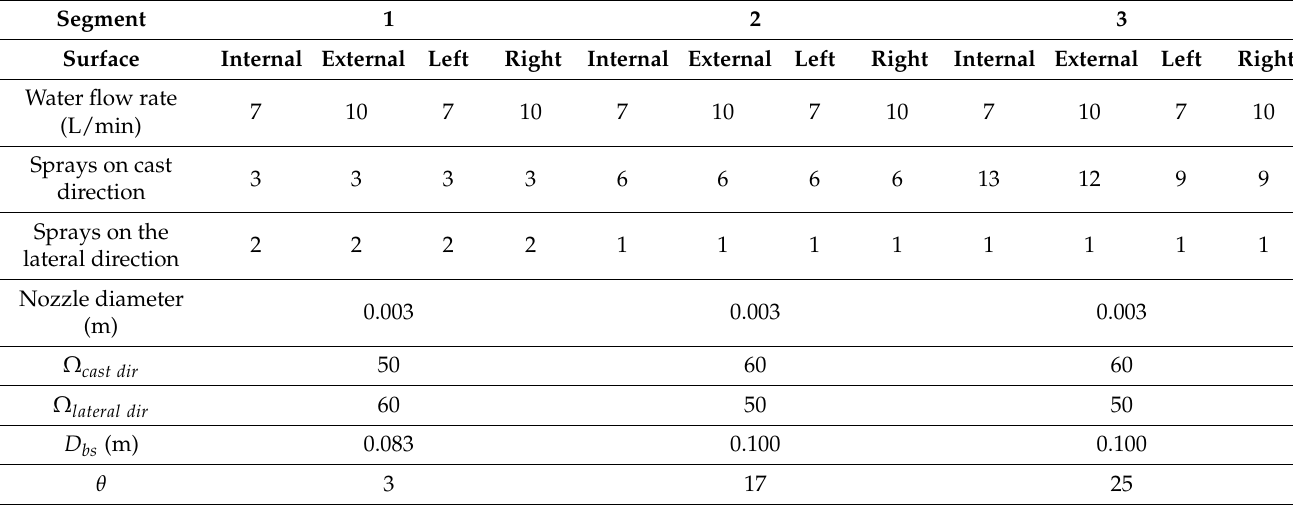
Table 4. Operating conditions of the SCS (segments 1, 2, and 3). Note: Int. = internal and Ext. = external.